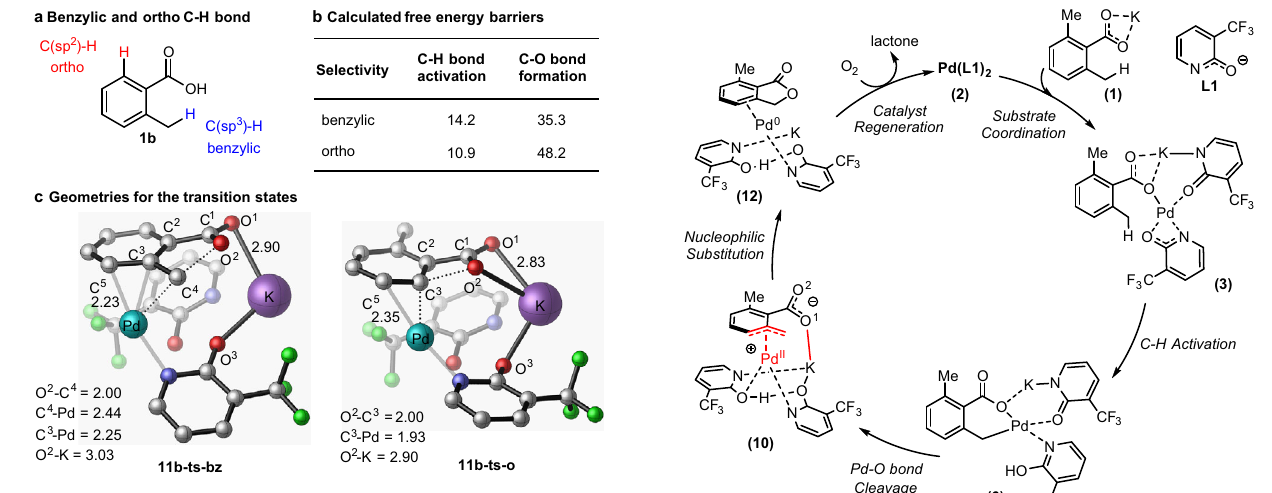
Fig. 7 Selectivity in C – H bond lactonization. a Benzylic and ortho C – H bonds; b Calculated free energy barrier for C – H bond activation and C – O bond formation (in kcal/mol), and c geometries for the key transition states (hydrogen atoms are omitted for clarity and bond distances are in Å).